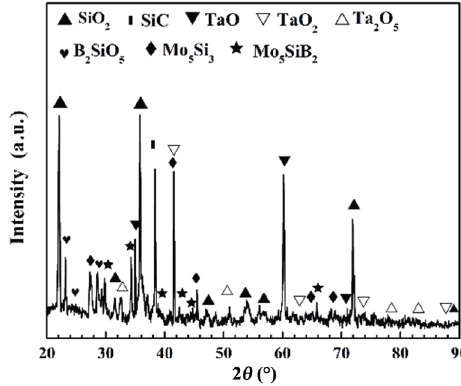
Fig. 9 Surface XRD pattern of the TaB 2 –MoSi 2 –SiC coating after